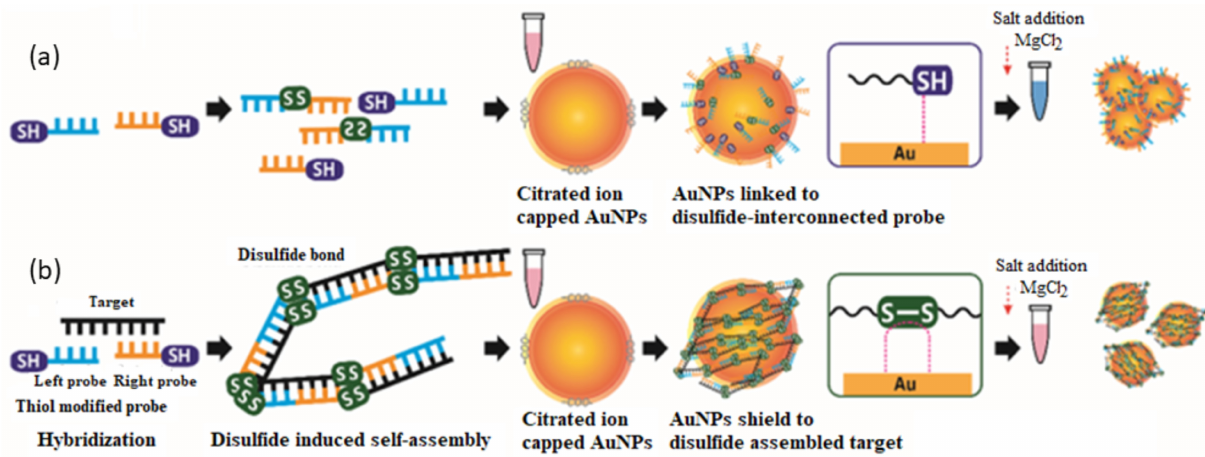
Figure 5. The schematic diagram demonstrated the formation of ( a ) a disulfide-induced interconnection between the AuNPs in the absence of target DNA and ( b ) disulfide-induced self-assembly in the presence of target DNA with the addition of MgCl 2 . Reproduced from Kim et al.